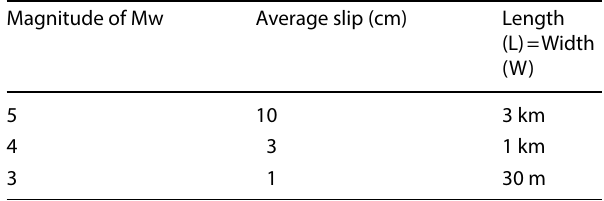
Table 2 Approximate source parameters for different magnitude earthquakes (partial magnitudes), with average stress drop (3 MPa) over a circular rupture (L = W) [59–63] Magnitude of